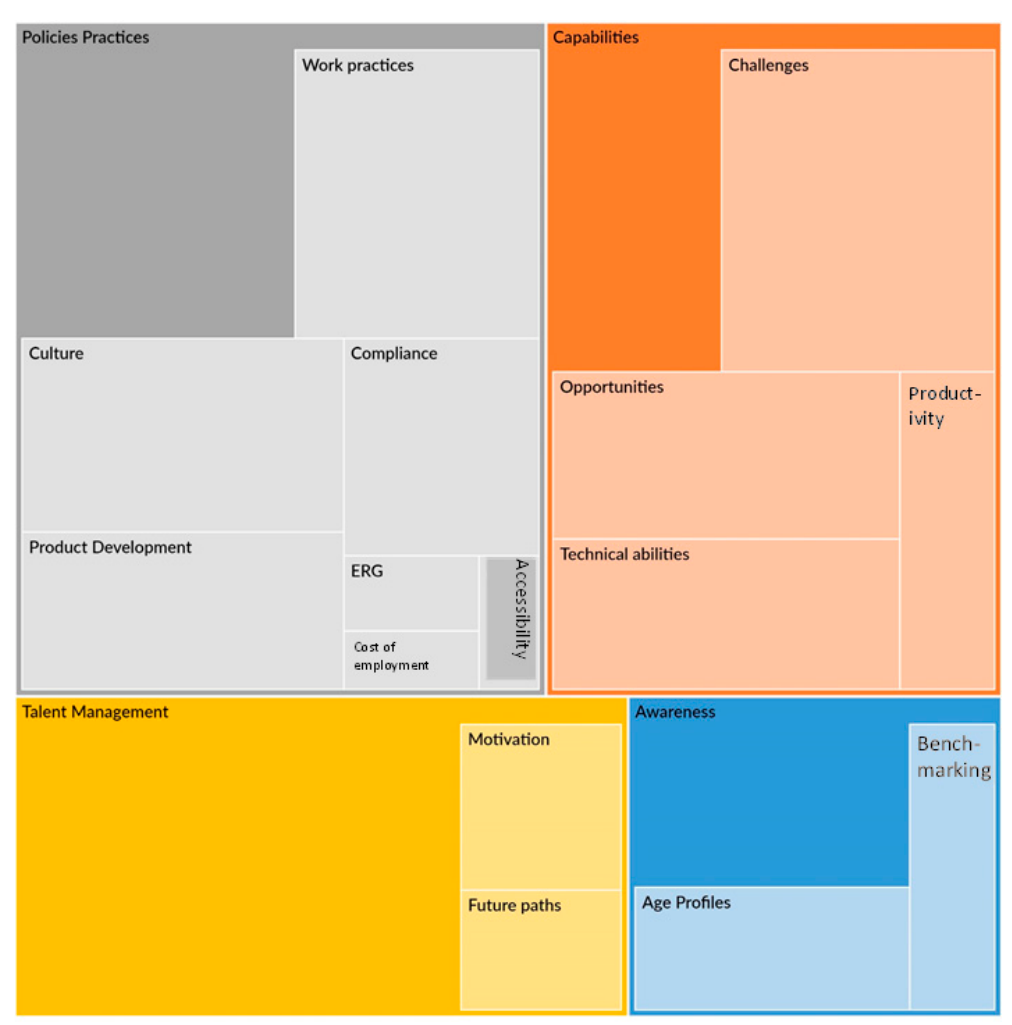
Figure 2. Hierarchy chart—codes and coding references. Cluster analysis offered a means of visualizing the grouping of frequently used Table 3. Expanded words with shared meaning or attributes, which helped the researcher to assess and vali- date potential themes. Figure 3 shows the high-level output from the cluster analysis.